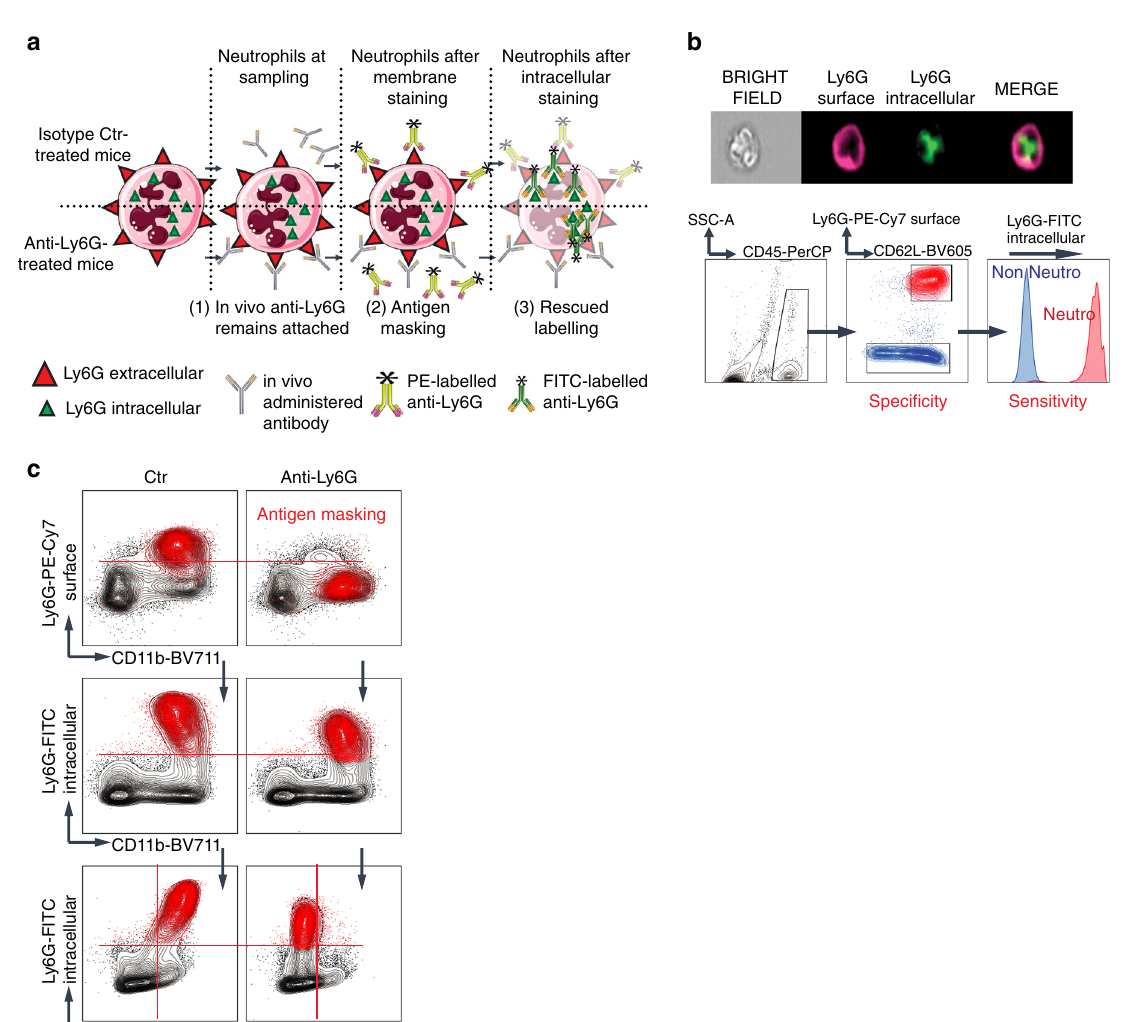
Fig. 1 Intracellular Ly6G staining overcomes surface Ly6G unavailability. a Schematic representation of the antigen masking related issue. Upon anti- Ly6G treatment, the in vivo delivered antibody remains bound to the surface antigen even after sampling, impairing fl uorochrome-labeled additional binding. In contrast, the intracellular antigen remains available. b (top) Representative image acquired with ImageStream of a neutrophil where the Ly6G antigen has been successively and speci fi cally stained on the membrane then in the intracellular compartment. (down) Representative fl ow cytometry analysis emphasizing the speci fi city and sensitivity of the intracellular Ly6G staining. c Mice were treated for 24 h with an isotype control (left) or anti- Ly6G (right) antibody, after which the bone marrows were sampled. CD45 + CD11b + Ly6G intra + neutrophils are shown in red. In the anti-Ly6G-treated group, cells were not detectable using the extracellular staining because of the